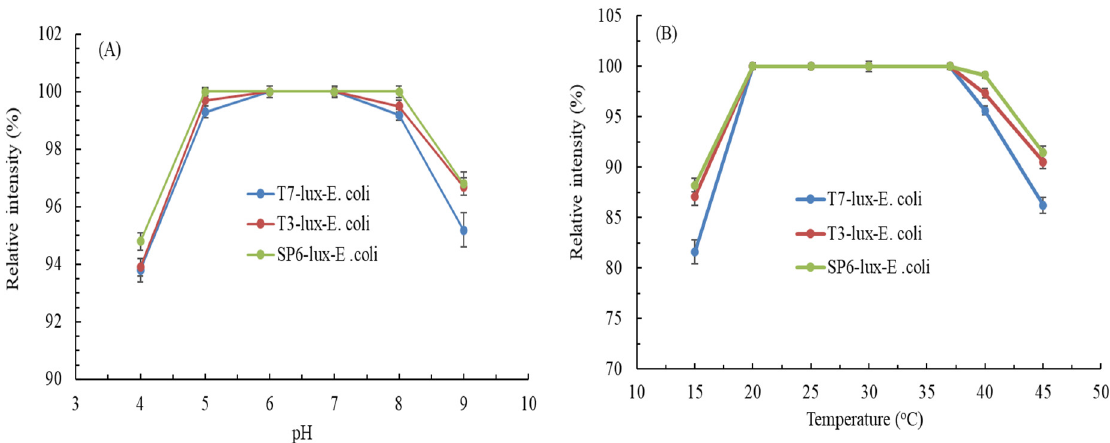
Figure 3. ( A ) Effects of pH on luminescence intensities of three recombinant E. coli biosensors induced with 0.5 mg/L Cr(VI). ( B ) Effects of incubation temperature on luminescence intensities of three recombinant E. coli biosensors induced with 0.5 mg/L Cr(VI) for 1.5 h (T7-lux- E. coli ), 1 h (T3-lux- E. coli ), and 0.5 h (SP6-lux- E. coli ).